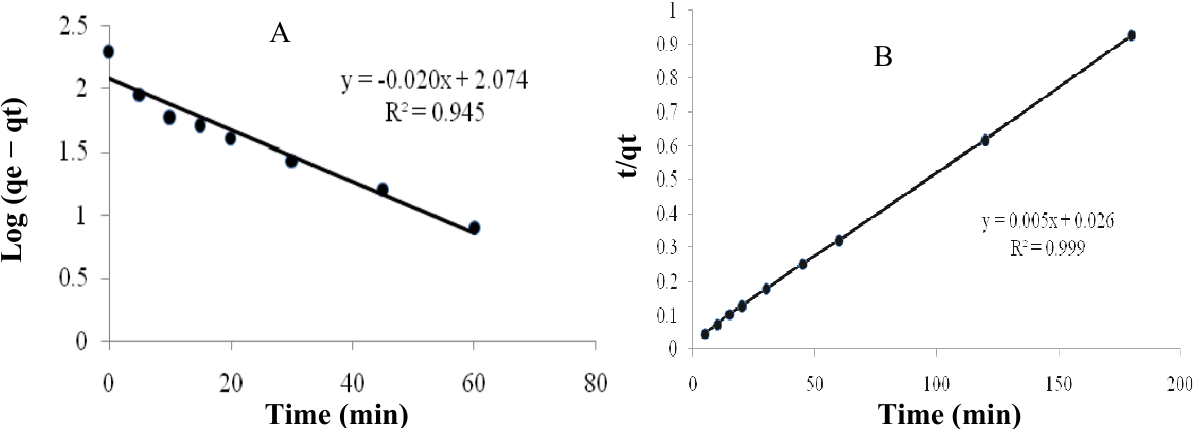
Figure 4. Pseudo-first-order (A) and pseudo-second-order (B) cadmium (II) biosorption by modified Tamrix articulata wastes.